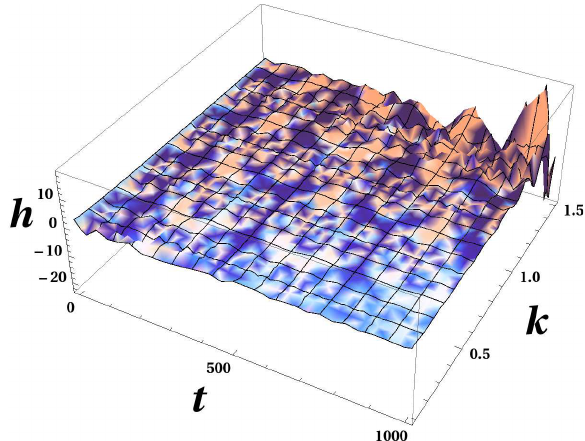
Figure 2. In this plot, we use the units M P = 1 and the values a 1 = − 1 and H = M P . The tensor perturbation mode h is shown as function of time t and of the initial frequency k . Until the values of k are small, there are no strongly growing solutions. However, when k gets closer to the Planck scale, the perturbations start to explode because of the high derivatives